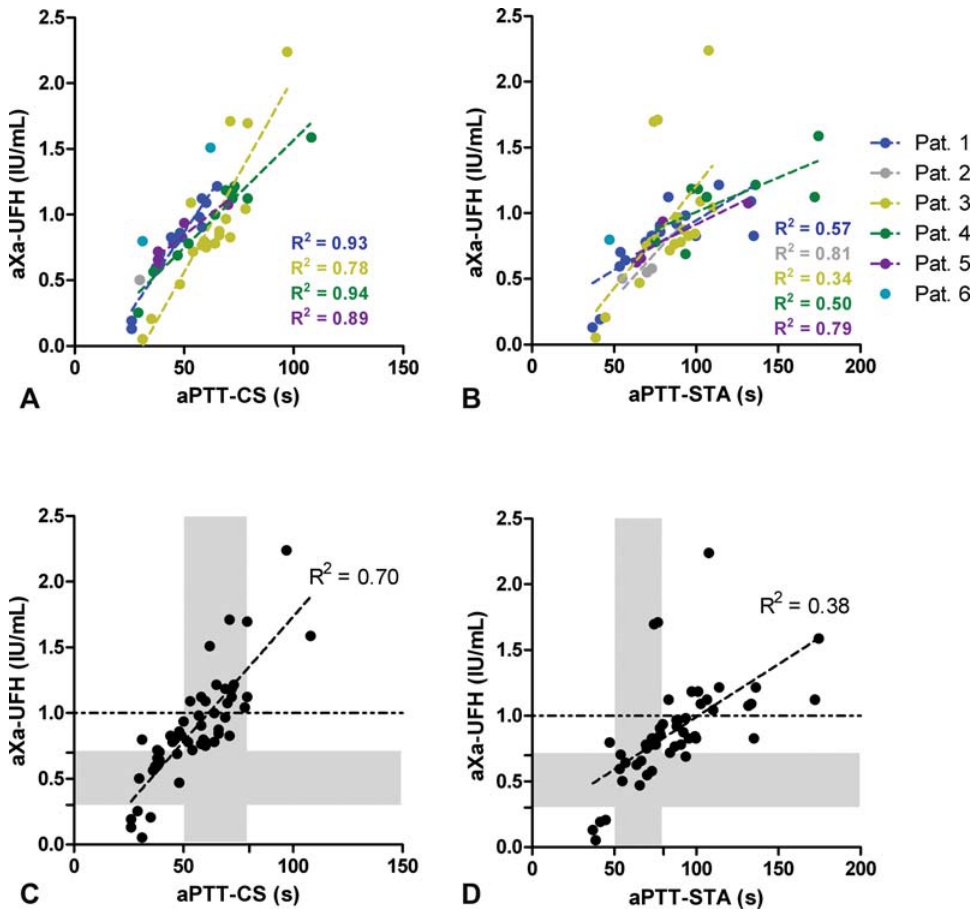
Fig. 3 Correlation between the anti-Xa activity and the activated partial thromboplastin time (aPTT) measured on the Sysmex CS2100i (aPTT- CS) per patient ( A ), Correlation between the anti-Xa activity and the aPTT measured on the Stago STA-R Max 2 (aPTT-STA) per patient ( B ), overall correlation between the anti-Xa activity and the aPTT-CS ( C ), and overall correlation between the anti-Xa activity and the aPTT-STA ( D ). Shaded areas indicate the heparin therapeutic range of the anti-Xa assay (0.3 – 0.7 IU/mL) and of the aPTT (50 – 80 seconds for both assays). Dashed lines indicate an anti-Xa activity of 1.0 IU/mL. LMWH, low-molecular-weight heparin; UFH, unfractionated